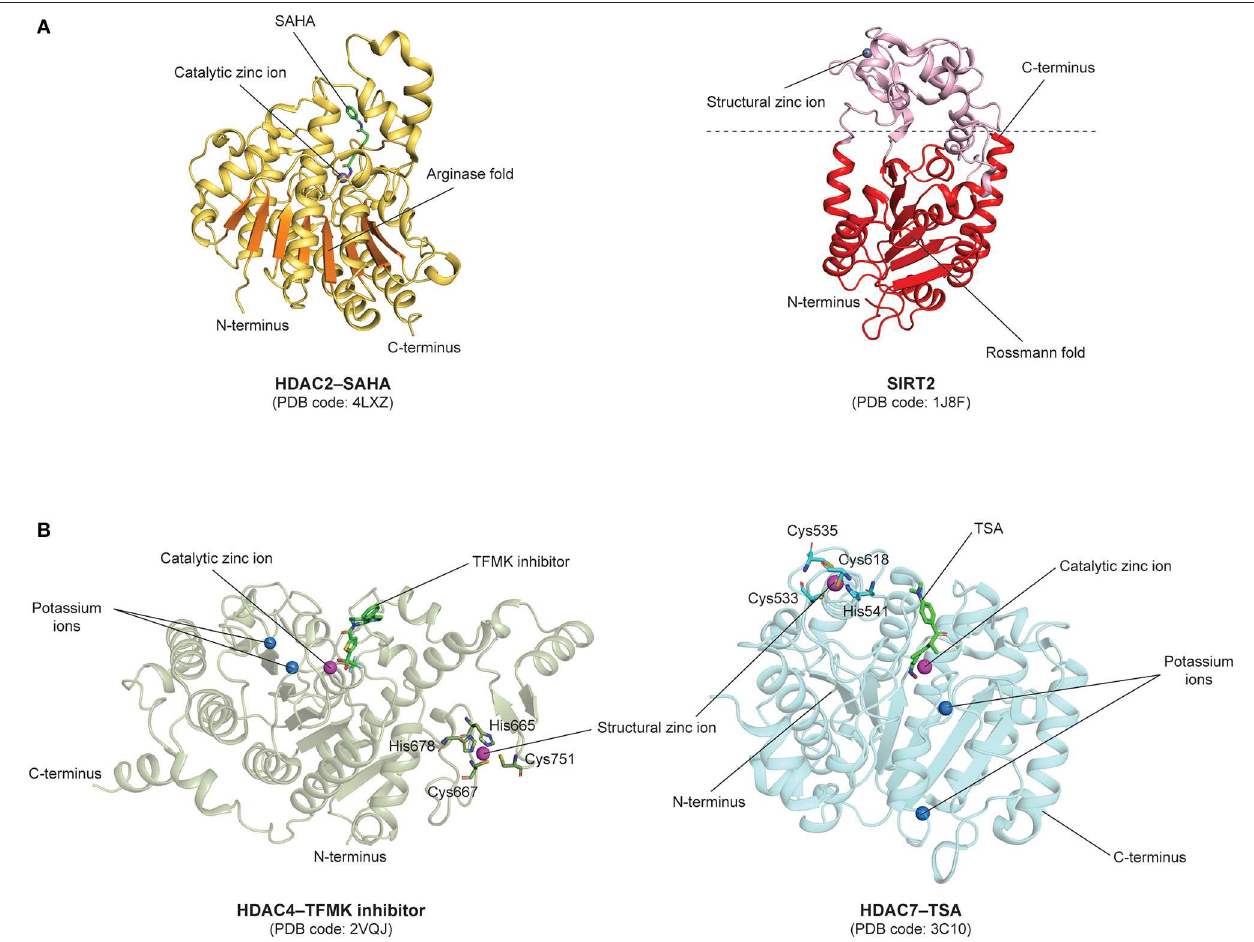
FIGURE 5 | Structural features of human HDACs. (A) Zinc- and NAD + -dependent classes HDACs: Catalytic domains of zinc-dependent HDAC2–SAHA (PDB code: 4LXZ ) comprising an arginase fold colored in orange, and NAD + -dependent SIRT2 (PDB code: 1J8F ) comprising a Rossmann fold colored in red. (B) Class IIa HDACs: HDAC4–TFMK inhibitor (PDB code: 2VQJ ) and HDAC7–TSA (PDB code: 3C10 ) structures comprising a catalytic zinc-binding domain and an additional structural zinc-binding domain. The structural zinc ions are coordinated by histidine and cysteine residues shown as